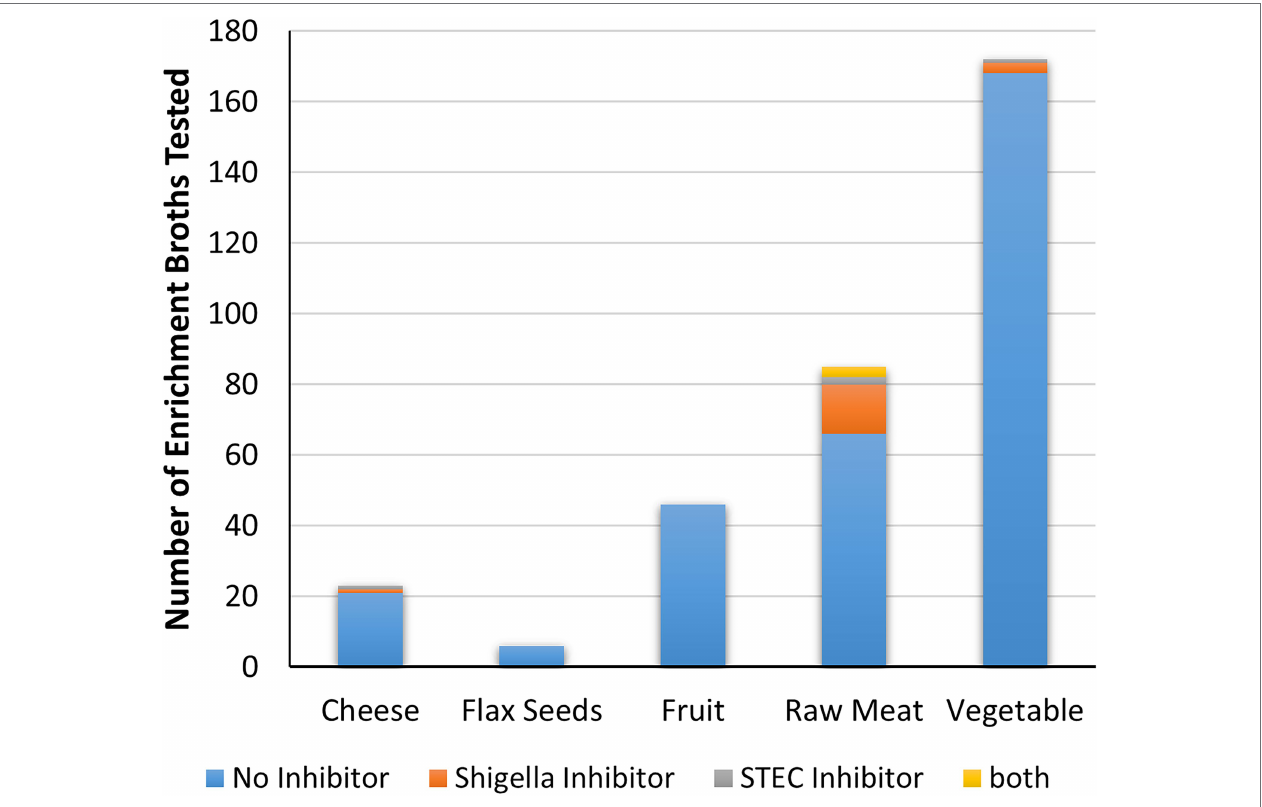
FIGURE 6 | Inhibitory activity of food enrichments on Shigella and STEC. The number of enrichment broths from each food category that did not produce inhibitors, or are inhibitory to either Shigella , STEC or both are